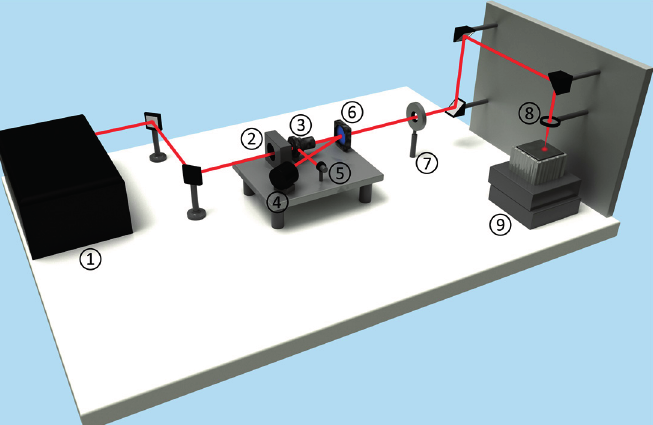
Figure 2. Typical setup for surface structuring ( 1 ) laser, ( 2 ) ½-wave plate, ( 3 ) polarizing beam splitter, ( 4 ) power meter, ( 5 ) beam dump, ( 6 ) beam sampler, ( 7 ) shutter, ( 8 ) focusing lens, and ( 9 ) 3-D